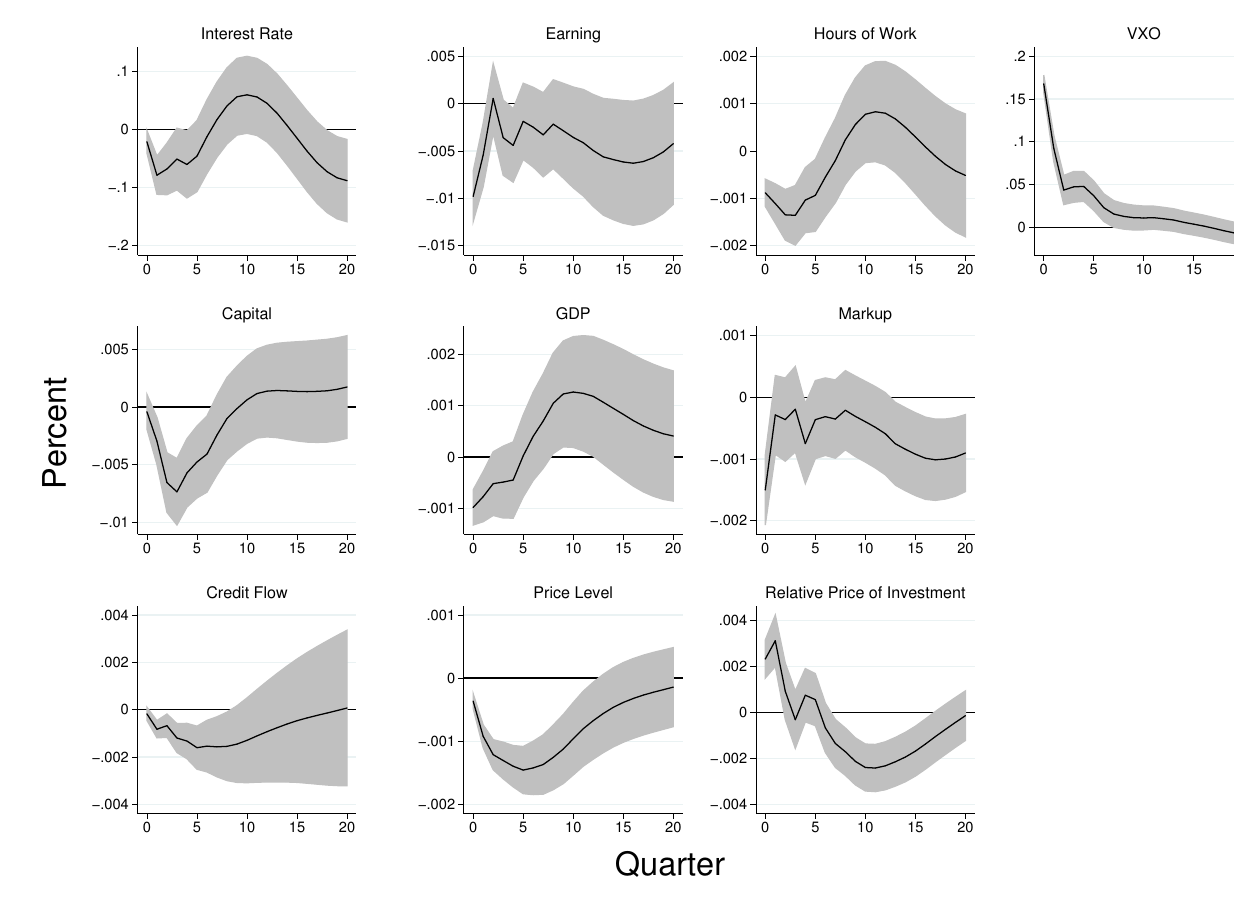
Figure A5. Effect of Uncertainty Shocks under Different Ordering of Variables. Notes : Shaded regions represent 90 percent standard error bands. The data are quarterly and span the period 1986Q1-2019Q4. With the exception of the federal funds rate, all the other variables are in log levels. The figure shows that output and markup decrease following an increase in uncertainty. Moreover, the correlation coefficient between simulated output and markup after uncertainty shock is computed to be 0.11, making markup